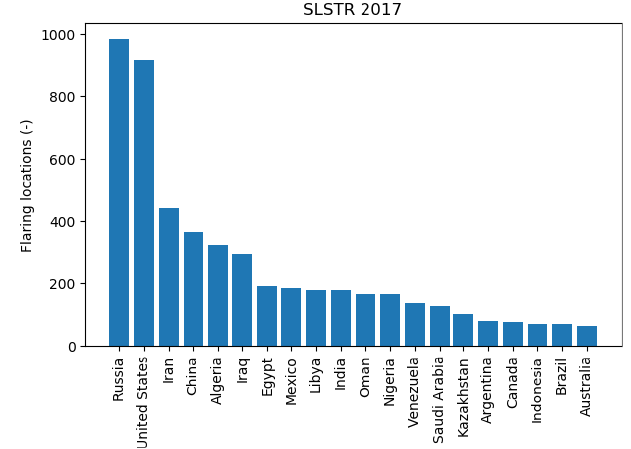
Figure 6. Number of flaring locations by country (top